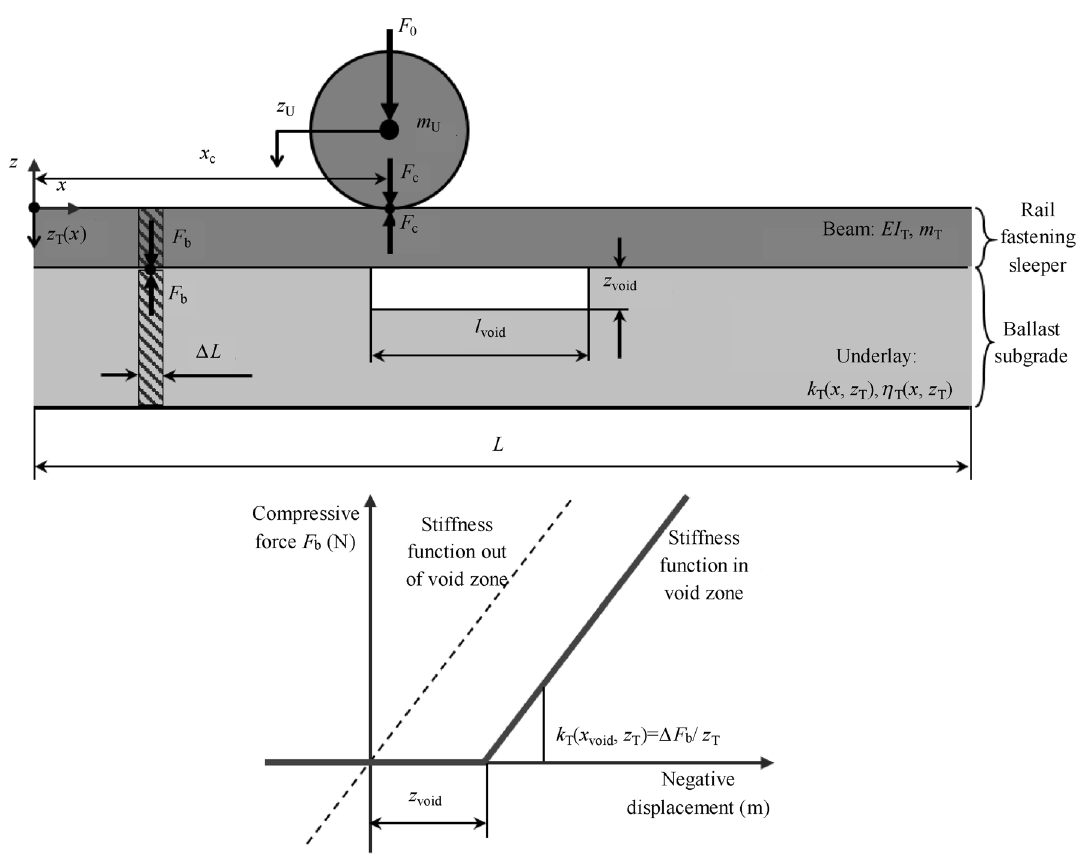
Fig. 8 Beam model of track and wheel